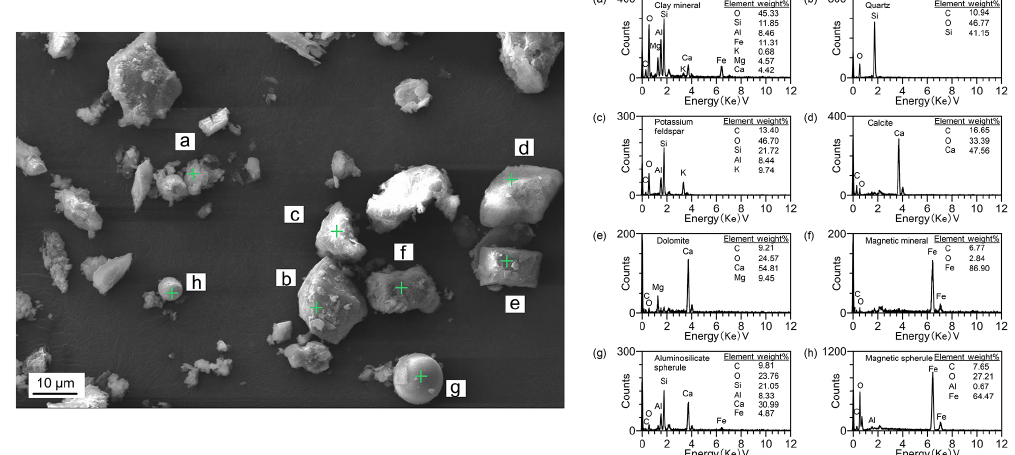
Figure 8. SEM photograph and elemental spectra for a typical sample of street dust. In the subplots, the green plus symbols denote the locations of the beam used in the EDS analysis.